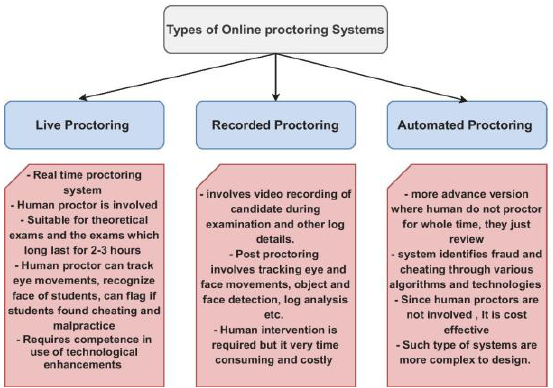
Figure 1 . Types of online proctoring